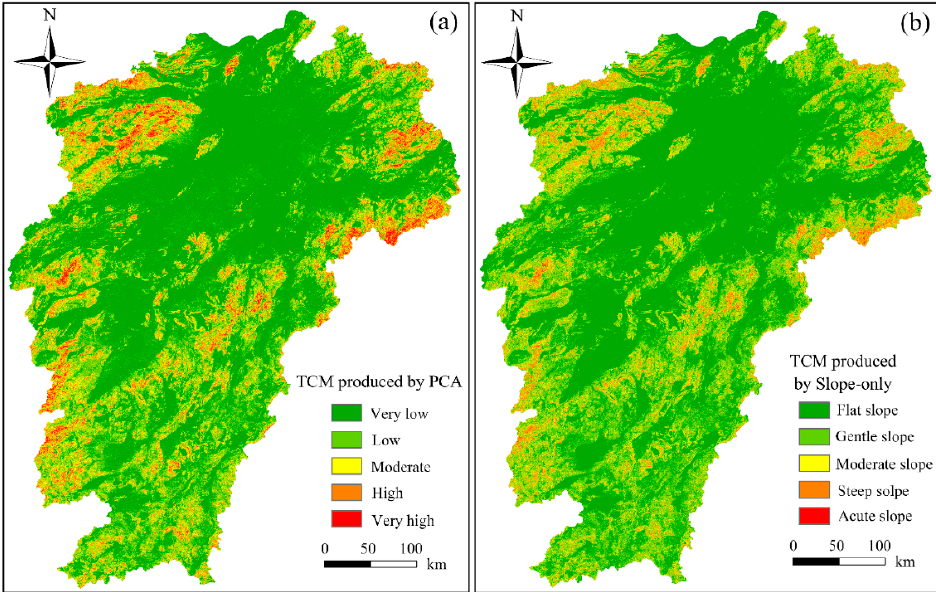
Figure 4. TCMs produced by the PCA ( a ) and slope-only ( b ) methods.